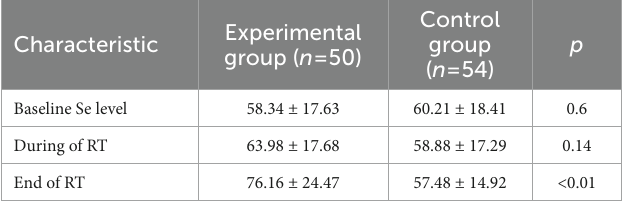
TABLE 5 Selenium levels ( μ g/L) between the two